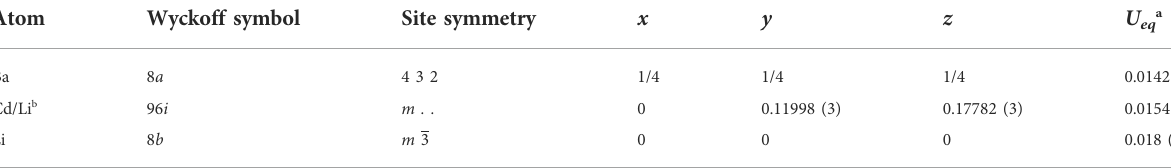
TABLE 2 Atomic coordinates and equivalent displacement parameters (Å 2 ) for BaLi x Cd 13 – x ( x ≈ 2). Atom Wyckoff symbol Site symmetry